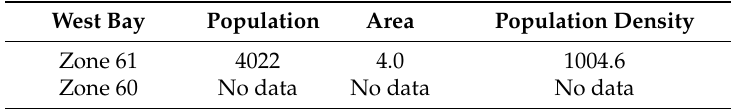
Table 1. West Bay Doha population density (source: author, retrieved from planning and statistics authority in